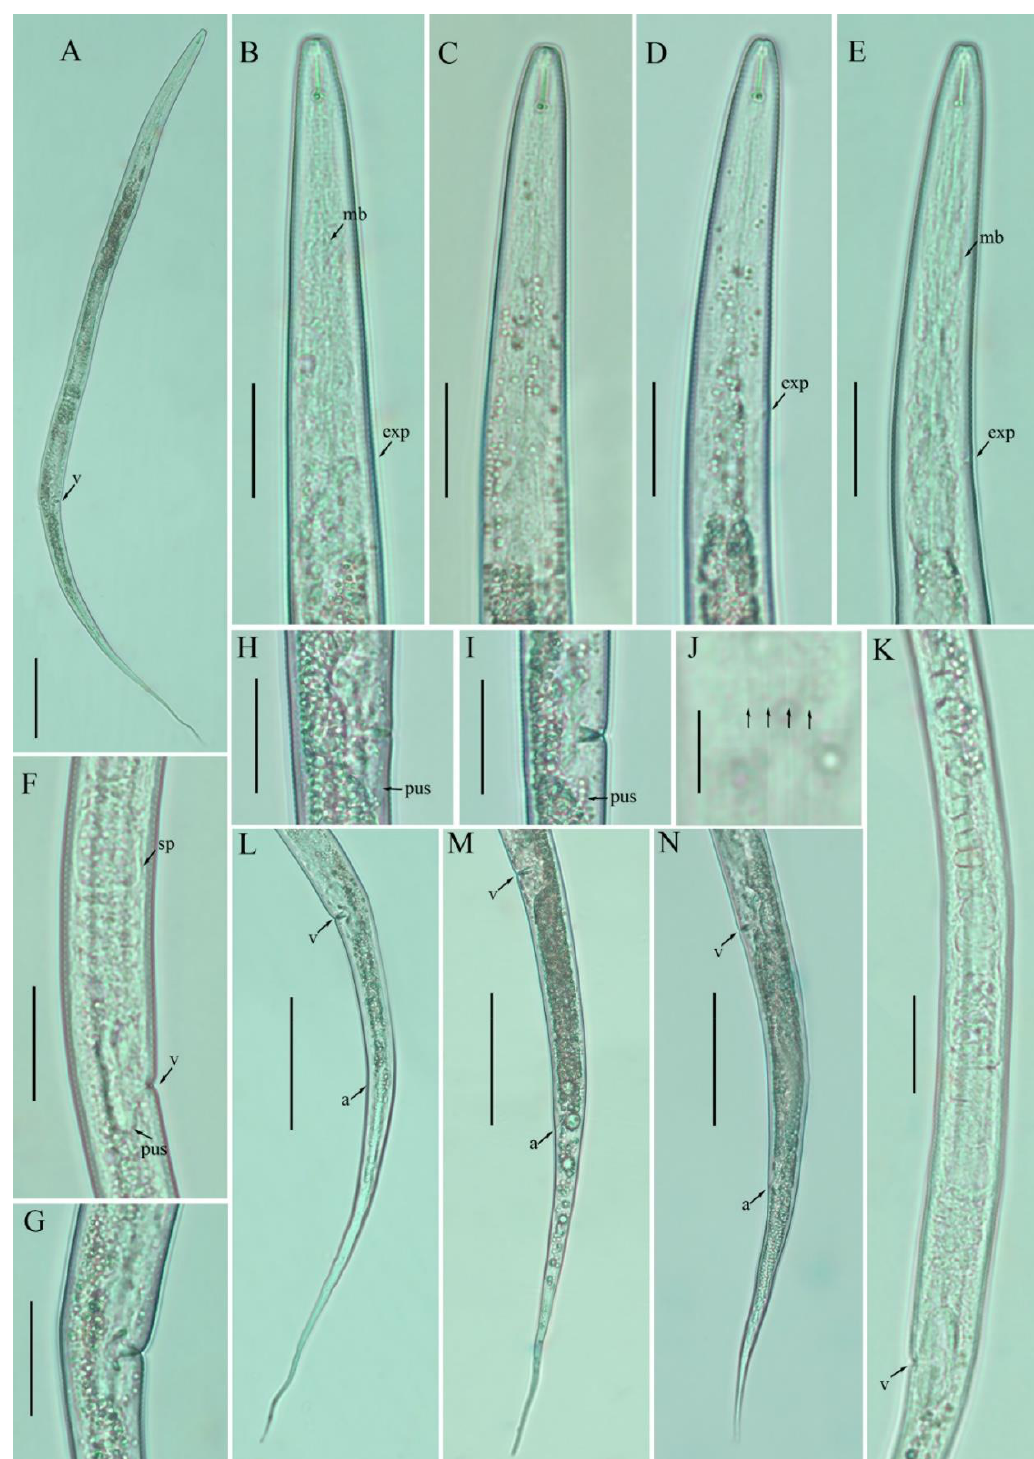
Figure 1. Photomicrographs of female Filenchus cylindricus (Thorne and Malek) Niblack and Bernard [18,19]. ( A ) Entire body; ( B – E ) pharyngeal regions; ( F – I ) vulval regions; ( J ) lateral field lines; ( K ) gonad; ( L – N ) posterior body to tail terminus. Scale bars: ( A ) 50 µm; ( C – I , K – N) 20 µm; ( J ) 5 µm. Arrowheads: (a) anus; (exp) excretory pore; (mb) median bulb; (PUS) post-uterine sac; (sp) spermatheca; (v) vulva.